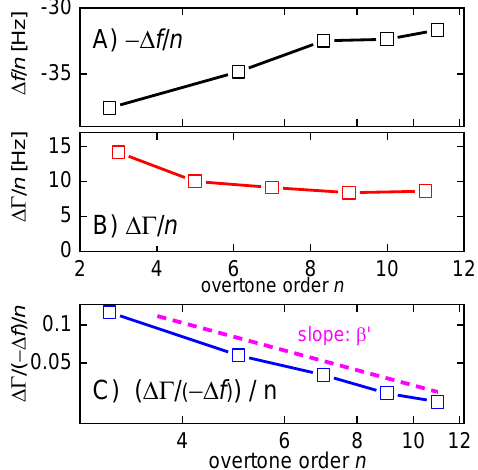
Figure 21. Soft adsorbates from a liquid phase produce sloped lines in plots of ∆ f / n in panel ( A ) and ∆Γ / n in panel ( B ) versus n . As opposed to the case of the soft film in air (Figure 17), the apparent mass as derived with the Sauerbrey equation is smaller than the true mass. Panel ( C ) shows ∆Γ /( − ∆ f ) normalized to overtone order. ∆Γ /( − ∆ f )/ n is proportional to J f (cid:48) (Equation (54)). The slope in this log-log plot is the power law exponent β (cid:48) (Section 4.7). The sample is a block copolymer adsorbed to the gold surface, where the soluble part forms a brush-like structure. Data kindly shared by Anna M.C. Maan, University of Groningen, FSE-Zernike Institute for Advanced Materi- als.